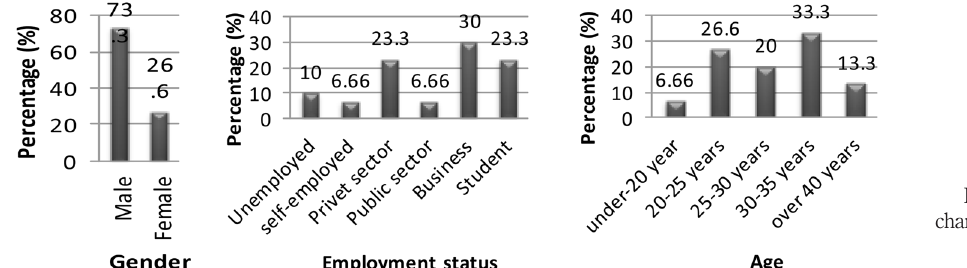
Figure 8. Demographic characteristics of